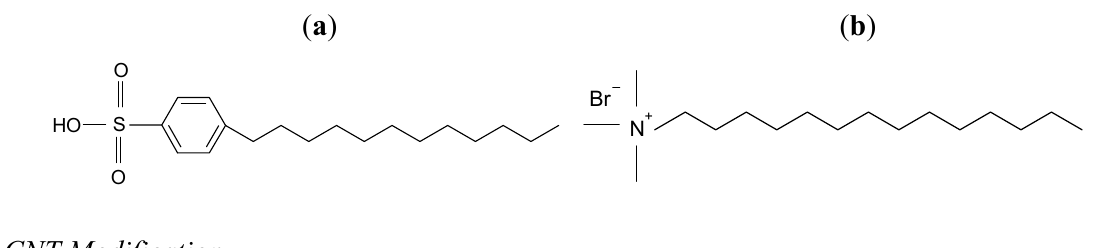
Figure 11. Chemical structure of ( a ) DBSA and ( b )